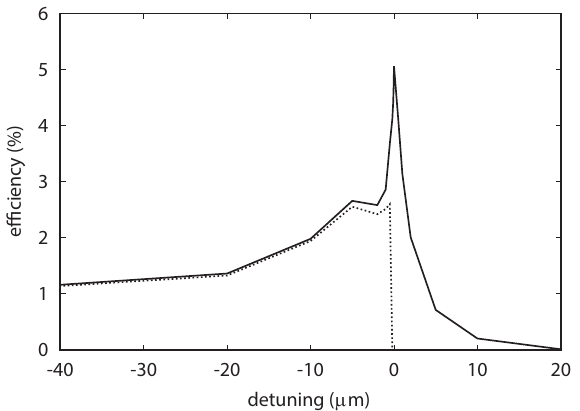
Figure 9. Cavity-length detuning curve calculated for the JAERI-FEL experiment with two different noise-factor: shot noise determined by the standard formula (solid line) and 10 − 12 of that (dashed line)